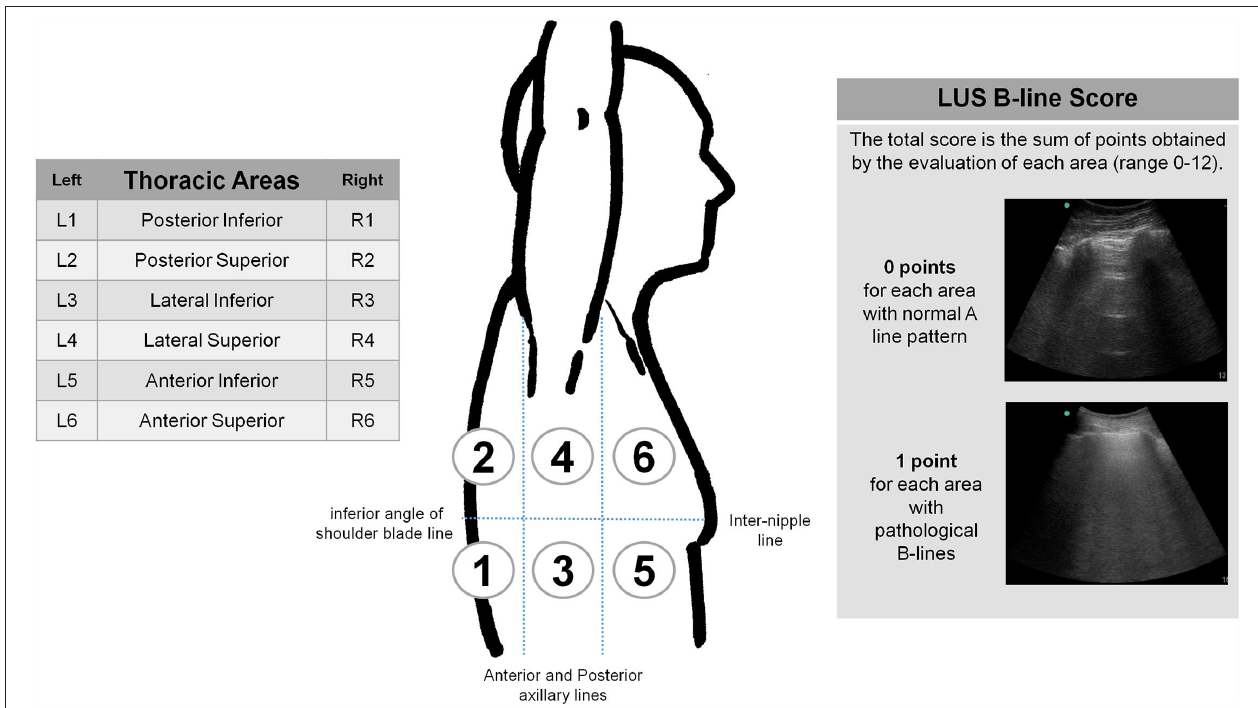
FIGURE 1 | Thoracic areas for LUS examination protocol. Anatomical landmarks: Anterior and posterior axillary lines (for anterior, lateral and posterior areas). Inter-nipple line and inferior angle of shoulder blade line (for superior and inferior areas). Sternum and vertebral spine (for right and left sides).